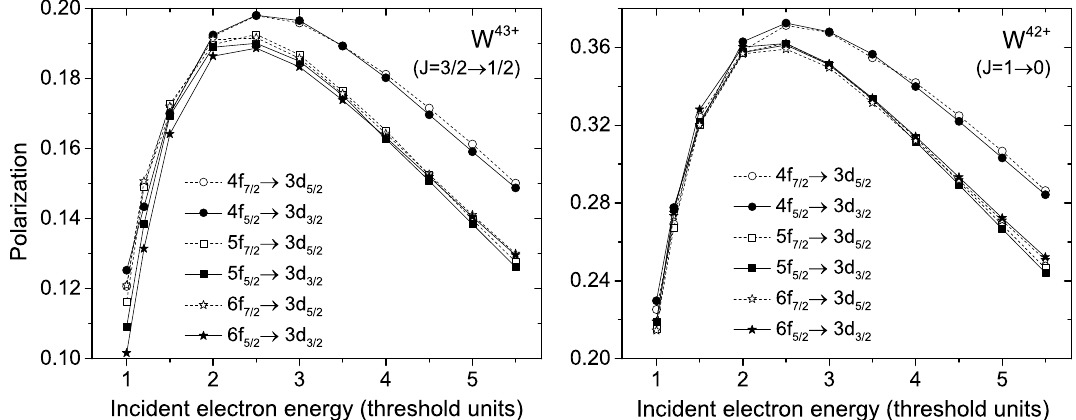
Figure 3. The presently calculated degrees of linear polarization of X-ray emissions following electron-impact excitations 3 d → nf ( n = 4 , 5 , 6 ) of W 43+ (left panel) and W 42+ (right panel) ions as a function of incident electron